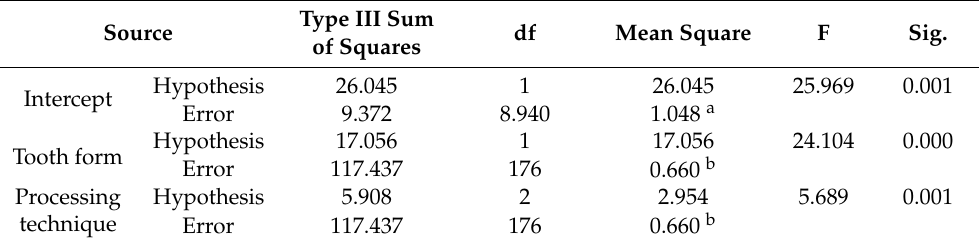
Table 3. Two-way ANOVA comparing the tooth forms and processing